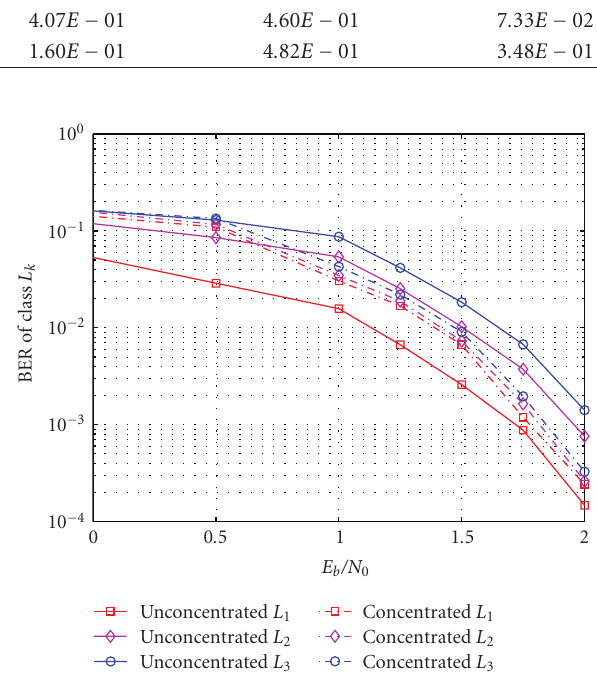
Figure 11: BERs of concentrated and nonconcentrated pruned check-irregular codes of rate 1/3 and length 1000 after 30 iterations for α (1) = 0 . 1, α (2) = 0 .